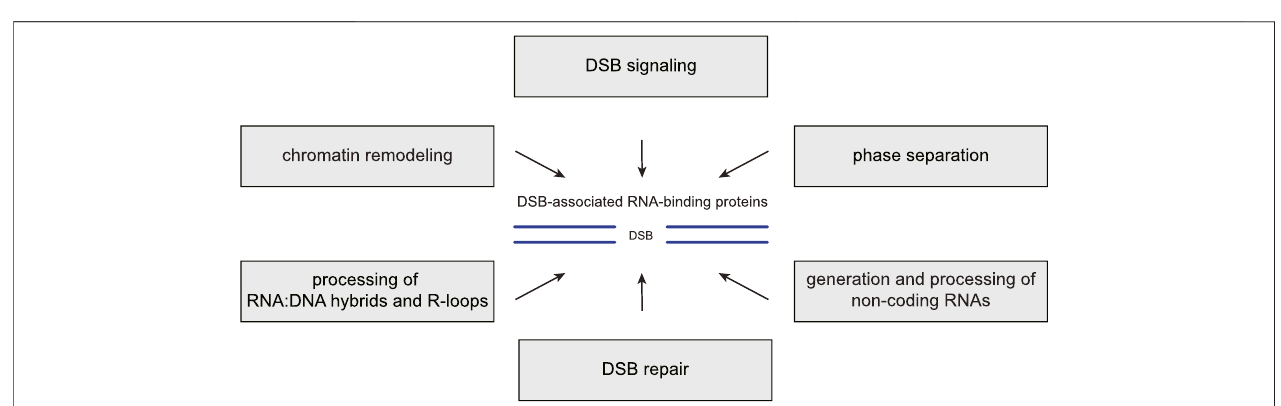
FIGURE 2 | RBP functions in the chromatin-based DSB response. Many RNA-binding proteins (RBPs) associate with DNA double-strand breaks (DSBs) and the surrounding chromatin where they carry out several distinct functions. First, they promote the recruitment or modulate the activities of DSB signaling and repair factors. Second,theyregulatelocal chromatin remodeling. Third,they contribute toliquid-liquid phaseseparationaroundthebreak site.Fourth,they prevent, resolve orstabilize RNA:DNA hybrids and R-loops. Fifth, they participate in the generation or processing of various non-coding RNA species at DSB sites.